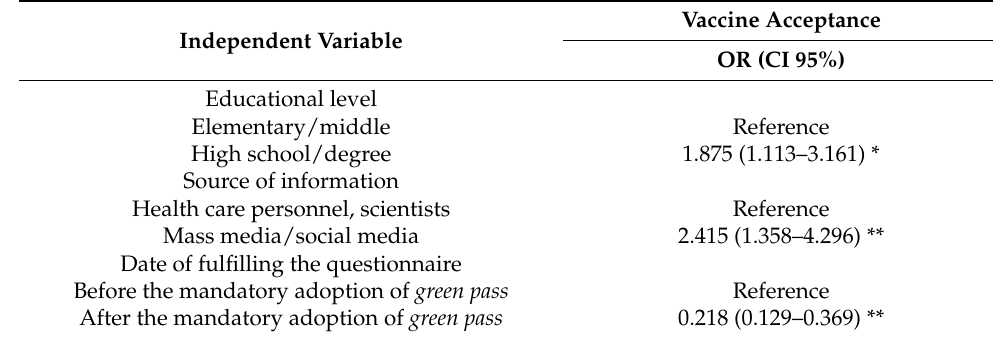
Table 4. Results of the logistic regression model built considering the acceptance of COVID-19 vaccination as the